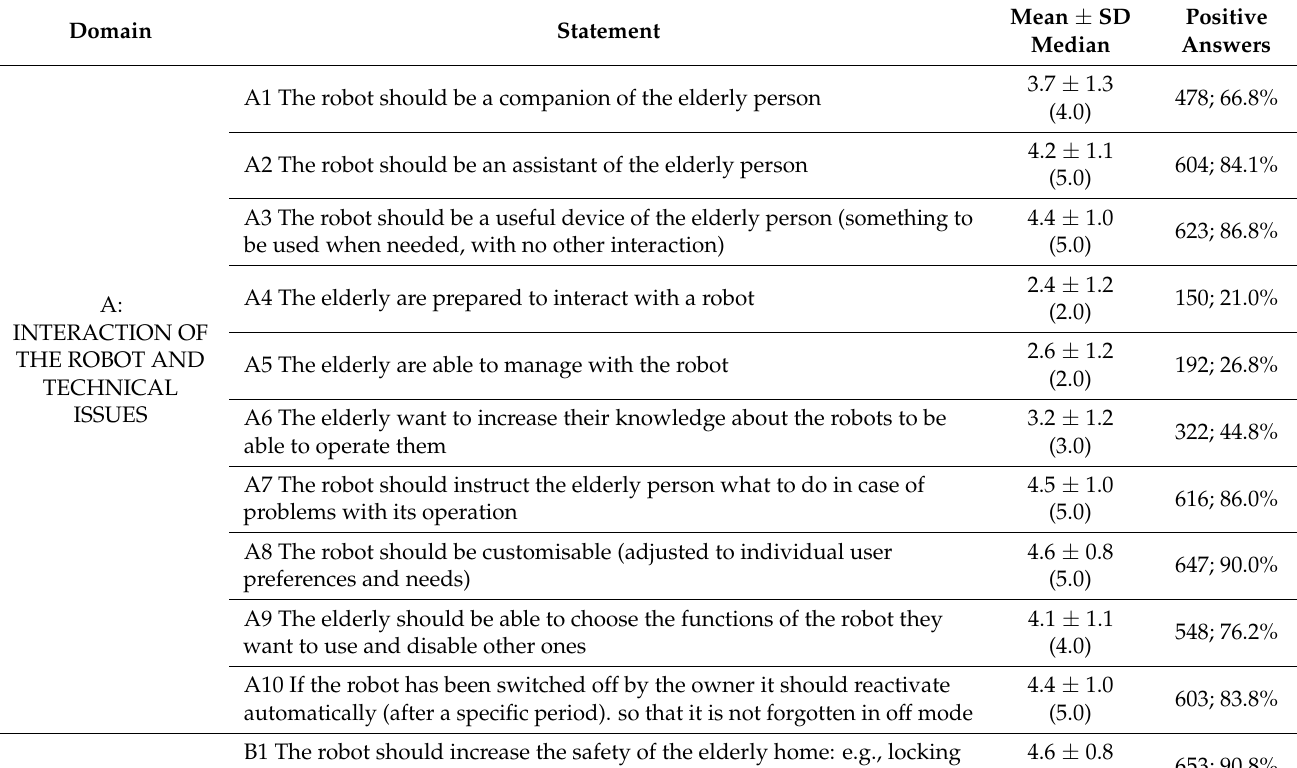
Table 1. Results for the individual UNRAQ